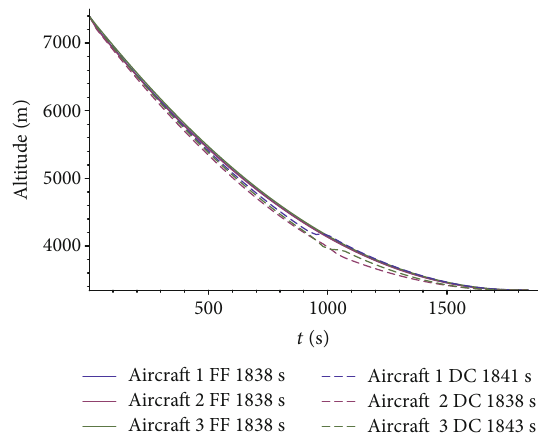
Figure 10: Experiment 2. Vertical pro fi les with (DC, dashed lines) and without (FF, solid lines) distance-based separation constraints.